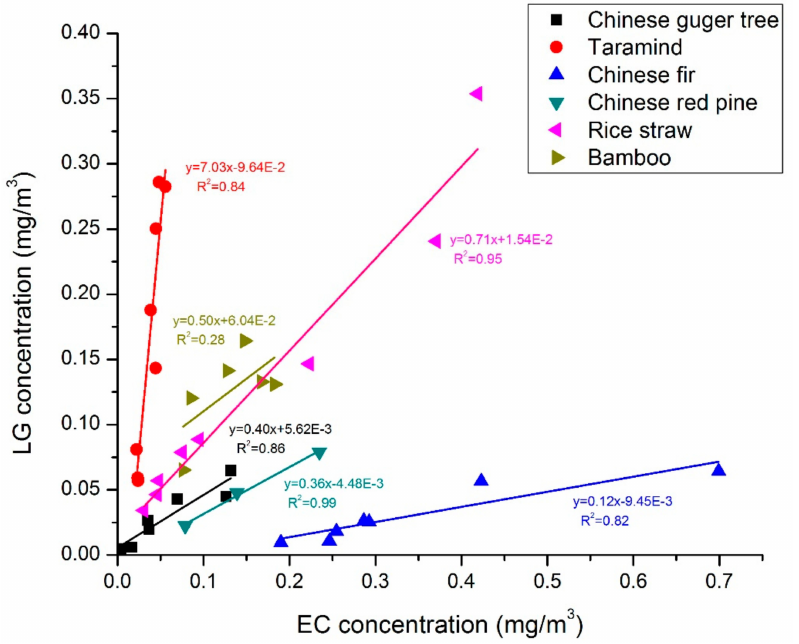
Figure 5. Correlations between LG and EC for di ff erent biofuel species.